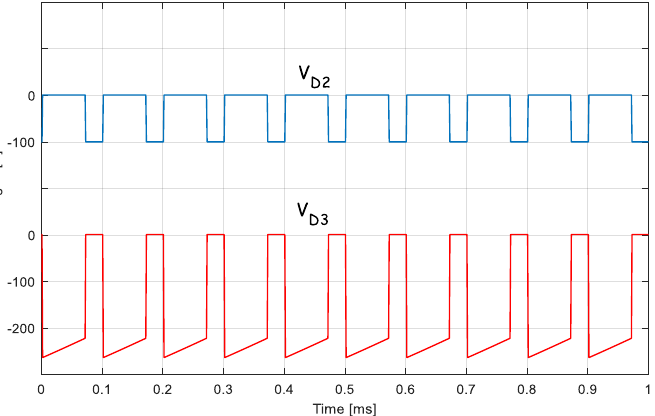
Figure 12. Simulation results of the voltage across the diodes D 2 and D 3 in boost mode.